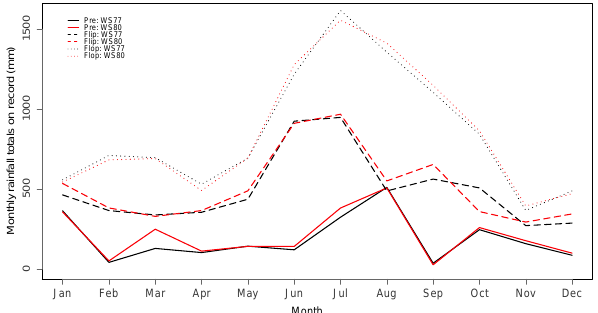
Fig. 5. Monthly rainfall totals in the two study watersheds grouped by the three eras; pre: 1969–1991, flip: 1992–2003, flop: 2004–2011. These data represent only concurrently measured rainfall in WS77 and WS80. Concurrently measured rainfall data in the two watersheds were available during 1990–1997, 2001–2008, and 2010–2011.